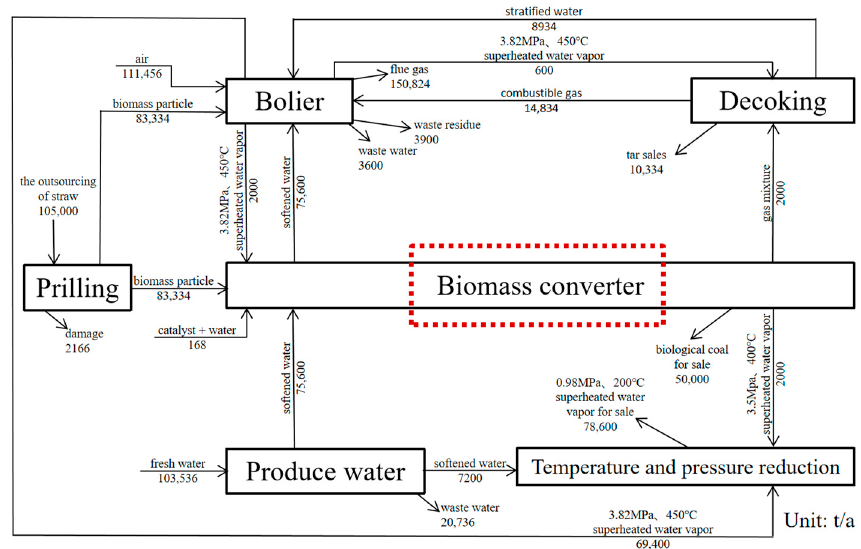
Figure 1. Production process design parameters of annual output of 50,000 tons of biochar.